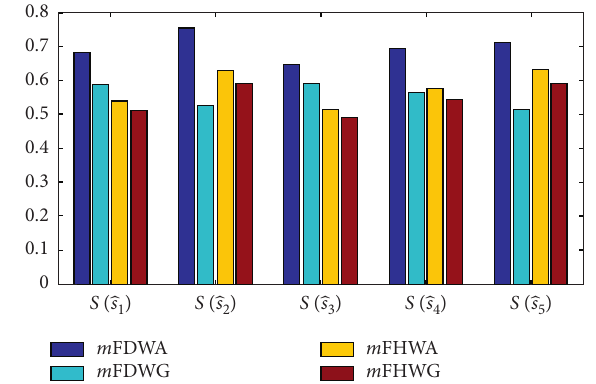
Figure 3: Comparison of first application in Section 5.1.